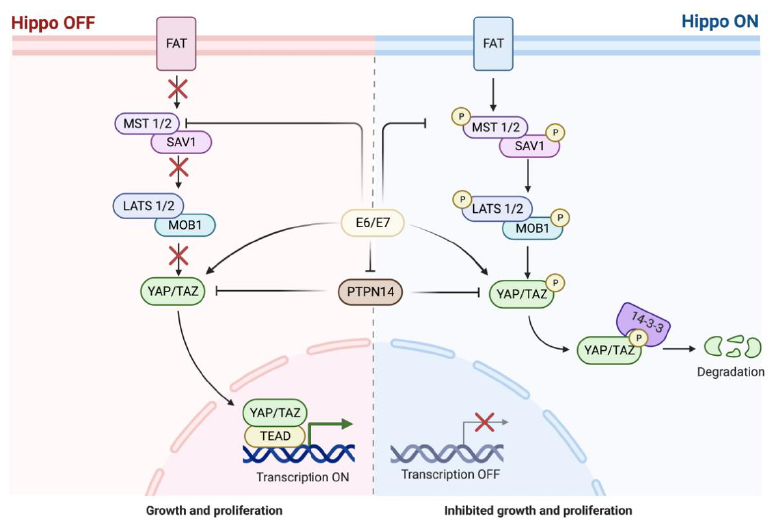
Figure 5. Hippo pathway with Human Papilloma Virus E6/E7 Oncoproteins. Adapted from “The Hippo Tumor Suppressor Pathway” and “Hippo Pathway in Mammals”, by BioRender.com (https://app.biorender.com/biorender-templates (accessed on 10 August 2022)).